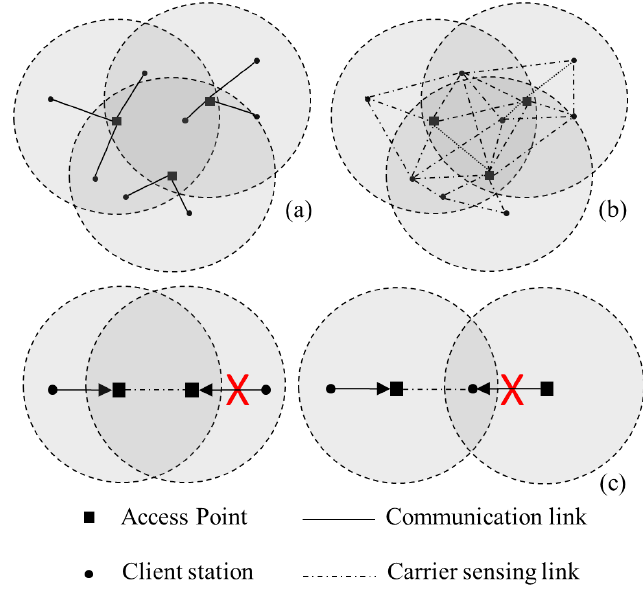
Figure 1. Example of co-channel interference in WLANs: ( a ) data communication topology; ( b ) carrier sensing topology; ( c ) cases of CCI through neighboring AP and neighboring client